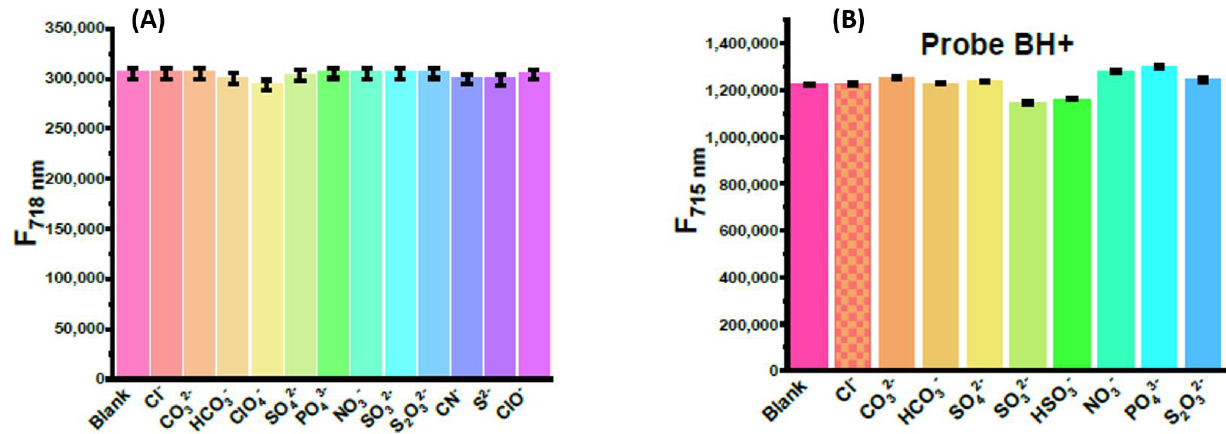
Figure 8. Fluorescence intensities of 10 μM probes AH + ( A ) and probe BH + ( B ) in the absence and presence of different cations (200 μM) in pH 7.4 buffers under excitation at 635 nm, respectively.